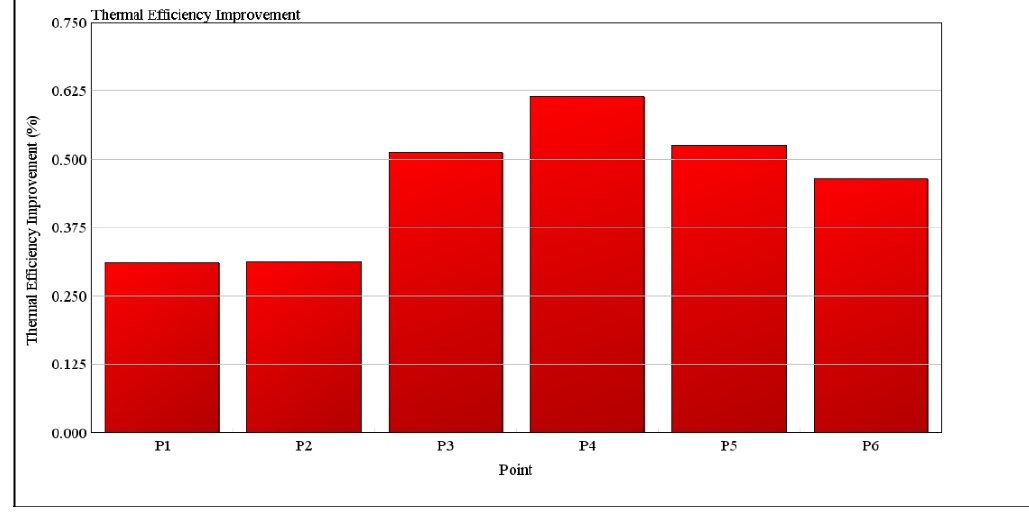
Figure 25. Thermal efficiency improvement.